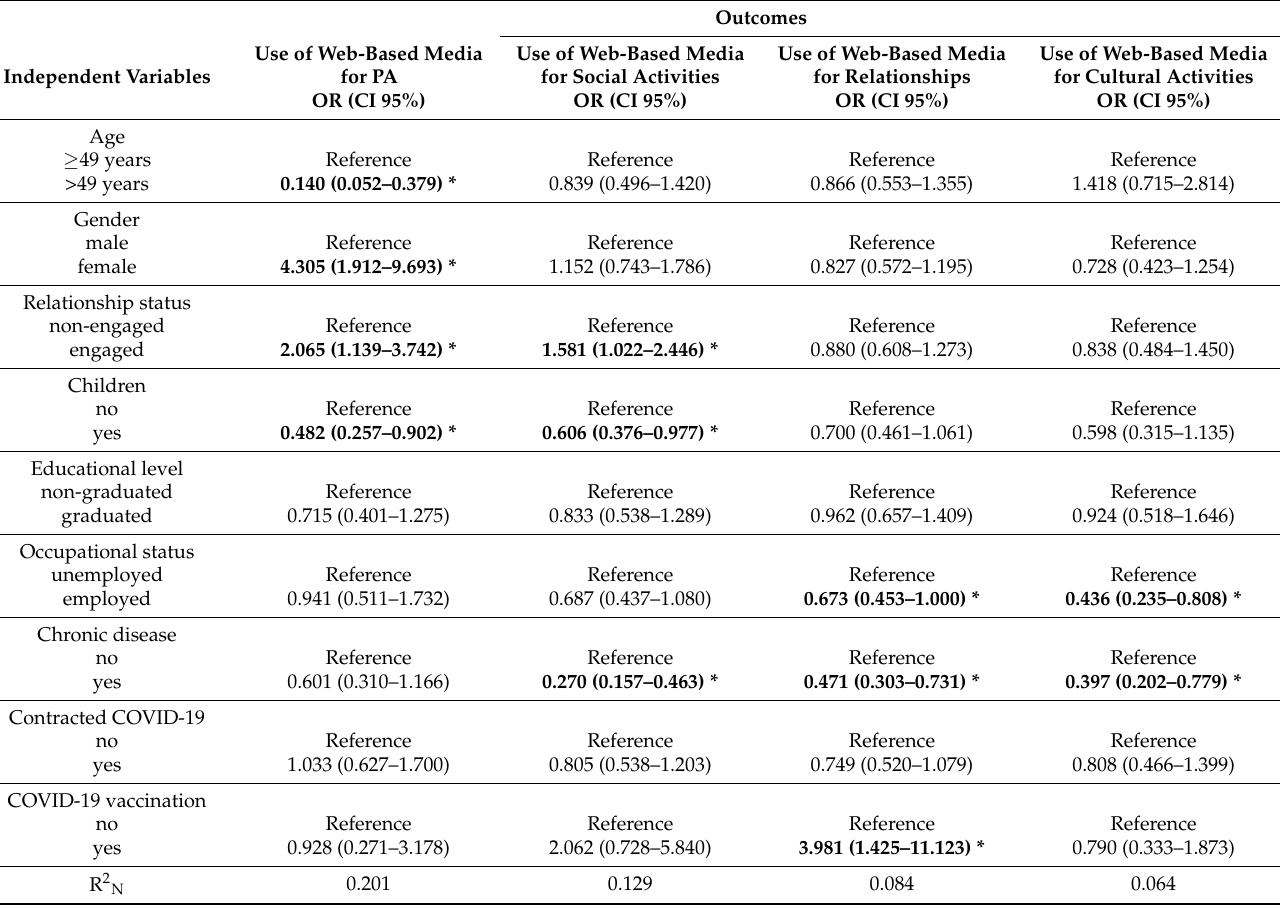
Table 3. Results of the regression analyses performed considering the use of web-based resources for PA, social activities, relationships and cultural activities during the pandemic as dependent variables, with related R-squared values for each